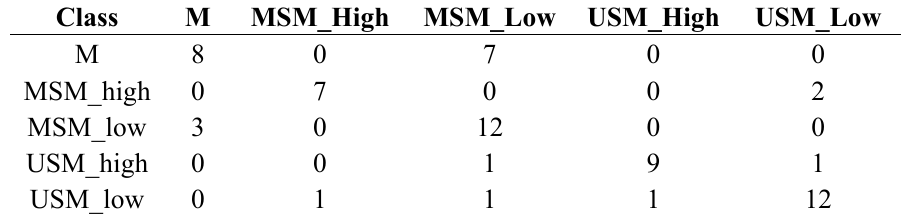
Table 2. K nearest neighbor (KNN) confusion matrix constructed by “leave-one-out” procedure over f-PCA of non-treated original cyclic voltammetric data sections of La Serenisima adulterated and non-adulterated milk. Adulterated milk samples were grouped divided into high or low adulteration level. High level was composed by MSM1 and MSM2 or USM1 and USM2, respectively. Low adulteration group was composed by MSM3, MSM4, and MSM5 or USM3, USM4, and USM5, respectively. M : Milk.